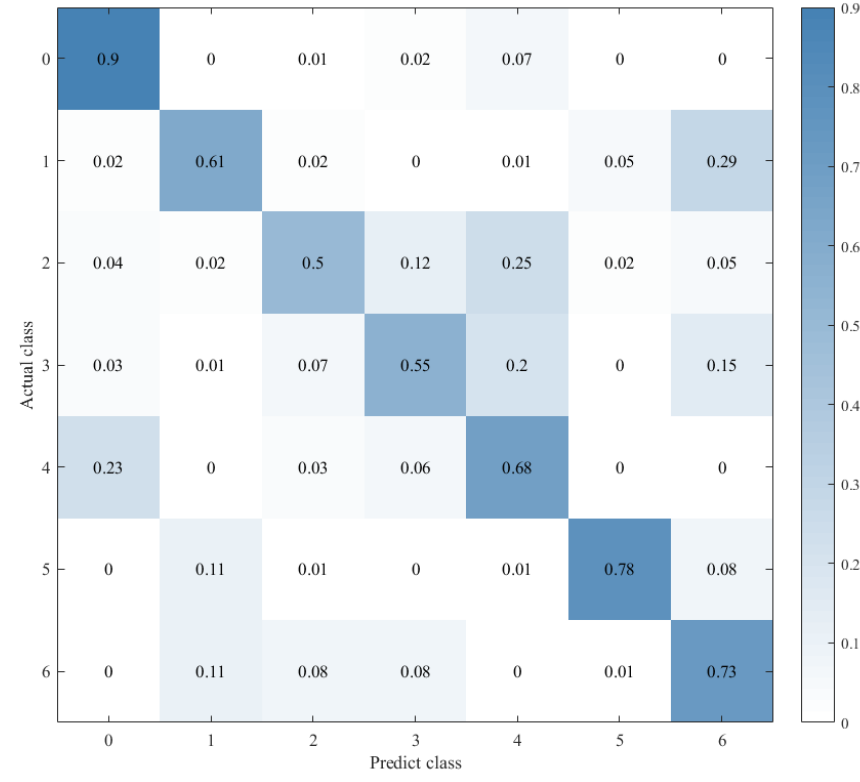
Figure 15. Confusion matrix for CNN+LSTM+Global-Attention+LSTM.